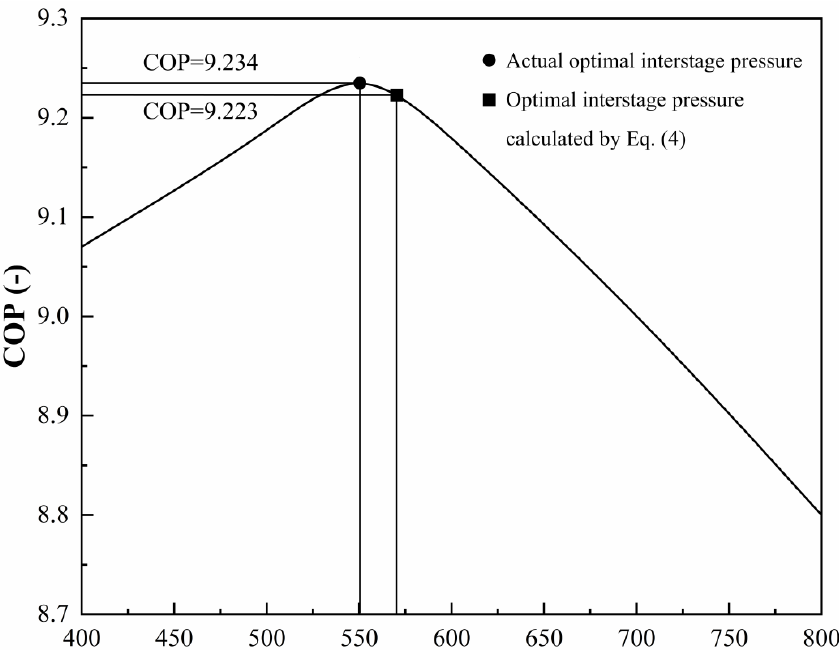
Figure 3. Effect of interstage pressure of the compressor on COP of the chiller.